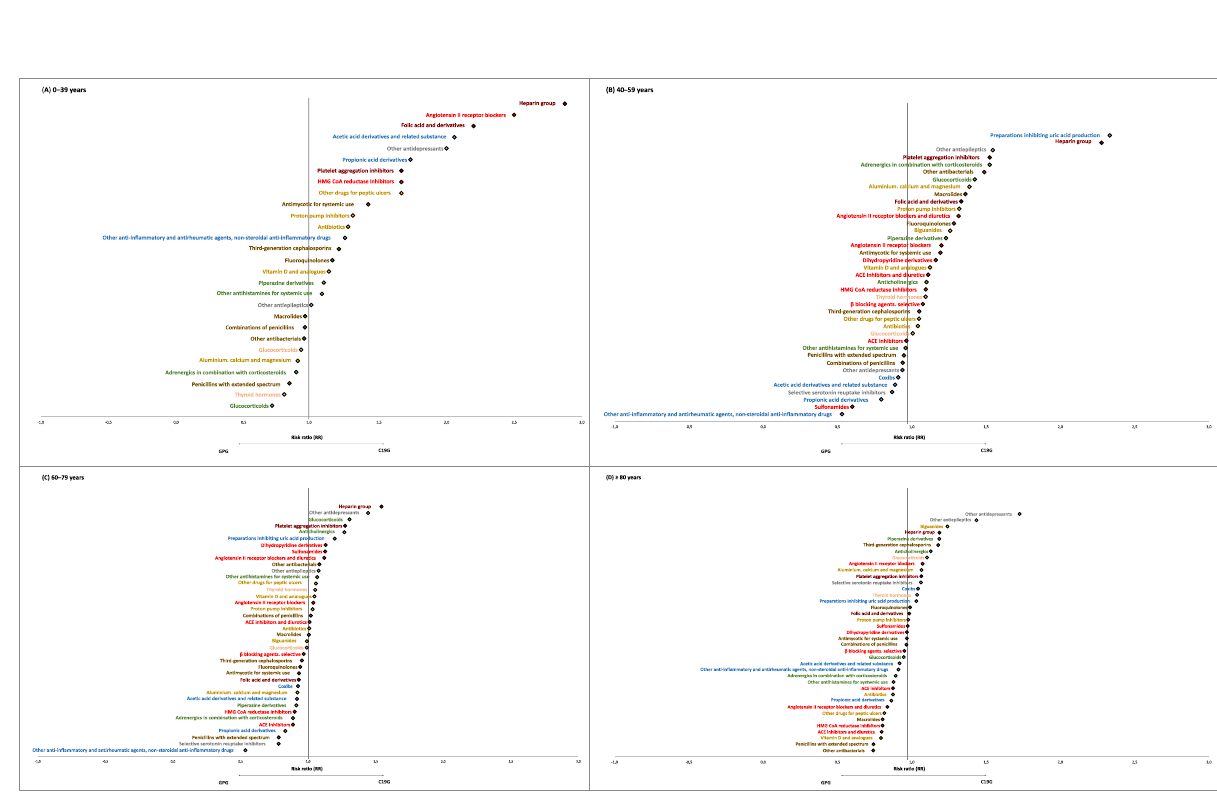
Figure 3. Chemical Subgroup of the C19G with the highest adjusted relative differences in prevalence stratified by age group. ( A ) Patients aged 0–39 years. ( B ) Patients aged 40–59 years. ( C ) Patients aged 60–79 years. ( D ) Patients aged >